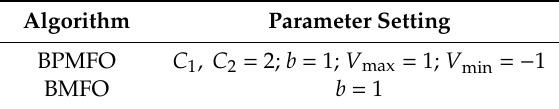
Table 10. Parameter setting of the validated